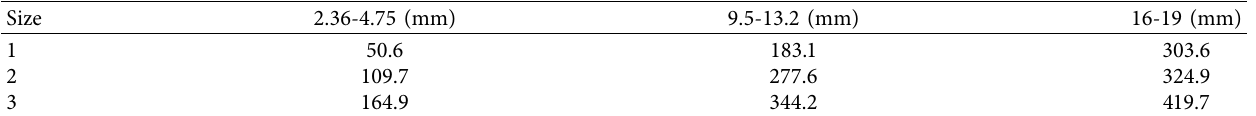
Table 6: Indoor gravel spread gravel weight (g).